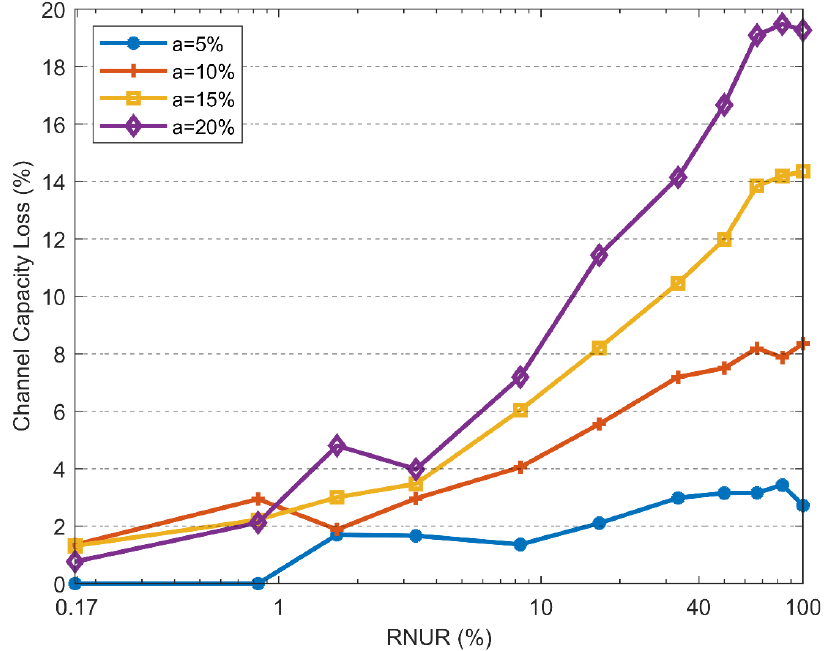
Figure 13. Channel Capacity Loss of the G3 PLC calculated with different values of the RNUR and the modulation index of the RPPM modulated DC ‐ DC converter at 60 kHz switching frequency. The performance of the G3-PLC for switching frequencies outside the PLC bandwidth are shown in Figures 14 and 15, respectively, confirming an increase in the FER when both the RNUR and the modulation index increase. However, the amount of variation in Figures 14 and 15 is insignificant compared to the results in Figure 10.